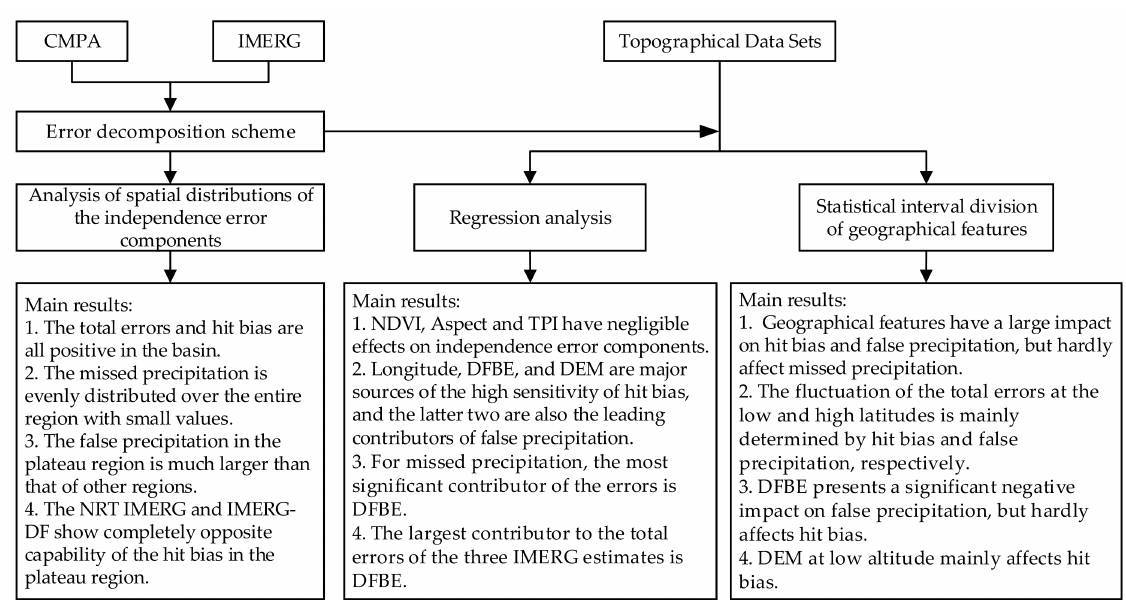
Figure 9. The flowchart of the analysis of independent error